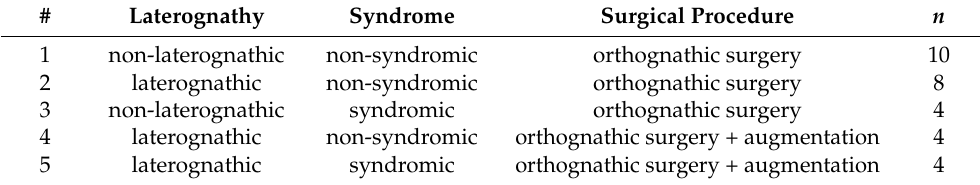
Table 1. Subdivision of patients into five groups.